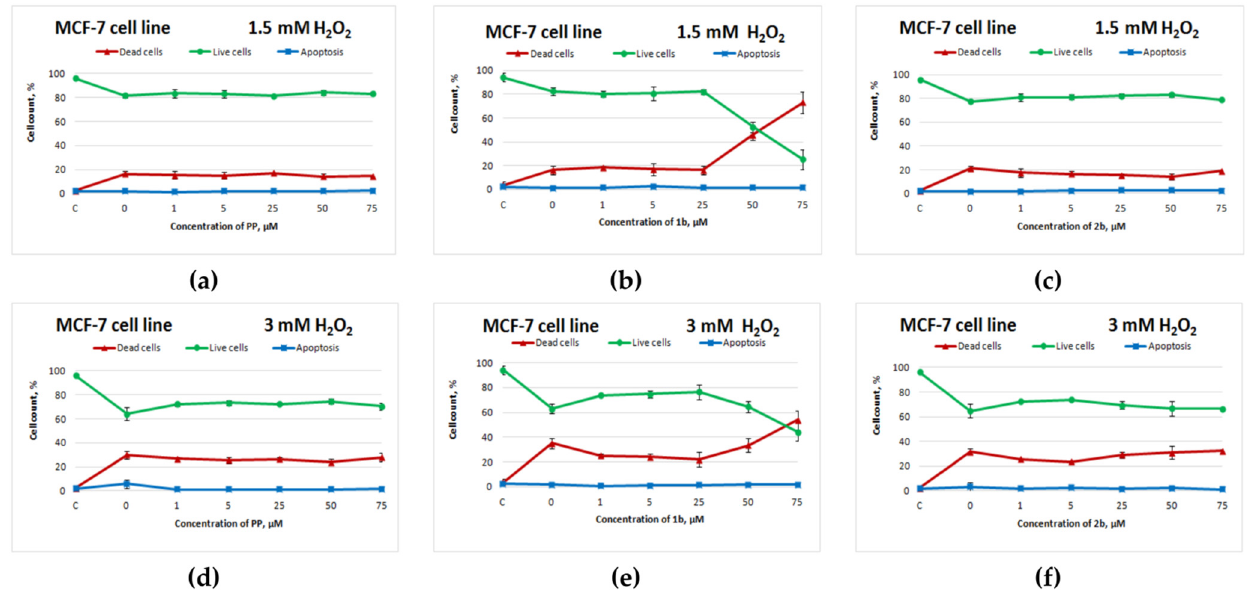
Figure 3. Effects of potassium phenosan [ PP , potassium 3-(3,5-di-tert-butyl-4-hydroxyphenyl)propionate], potassium 3-[3-(3,5-di-tert-butyl-4-hydroxyphenyl)propylseleno]propionate ( 1b ) or potassium 3-[4-hydroxy-3,5-dimethylbenzylthio]propanoate ( 2b ) on the viability of MCF-7 cells under the in- fluence of H 2 O 2 as determined by dual staining with Hoechst 33342/propidium iodide. Cells were cultured in the presence of each salt for 24 h, after which they were exposed to H 2 O 2 for 4 h. Point C represents control cells without treatment with hydrogen peroxide. ( a – c )—effect of PP , 1b and 2b on the viability of tumour cells under the influence of 1.5 mM H 2 O 2 , respectively, ( d – f )—effect of PP , 1b and 2b on the viability of tumour cells under the influence of 3 mM H 2 O 2 , respectively. The sulphur-containing analogue of potassium phenosan( 2b ) had a similar negative effect on the Hep-2 cell line: starting from 5 µM, cell death increased (Figure 4d,f). Compound 1b manifested an antioxidant activity toward Hep-2 cells that was superior to that of potassium phenosan (Figure 4d,e).